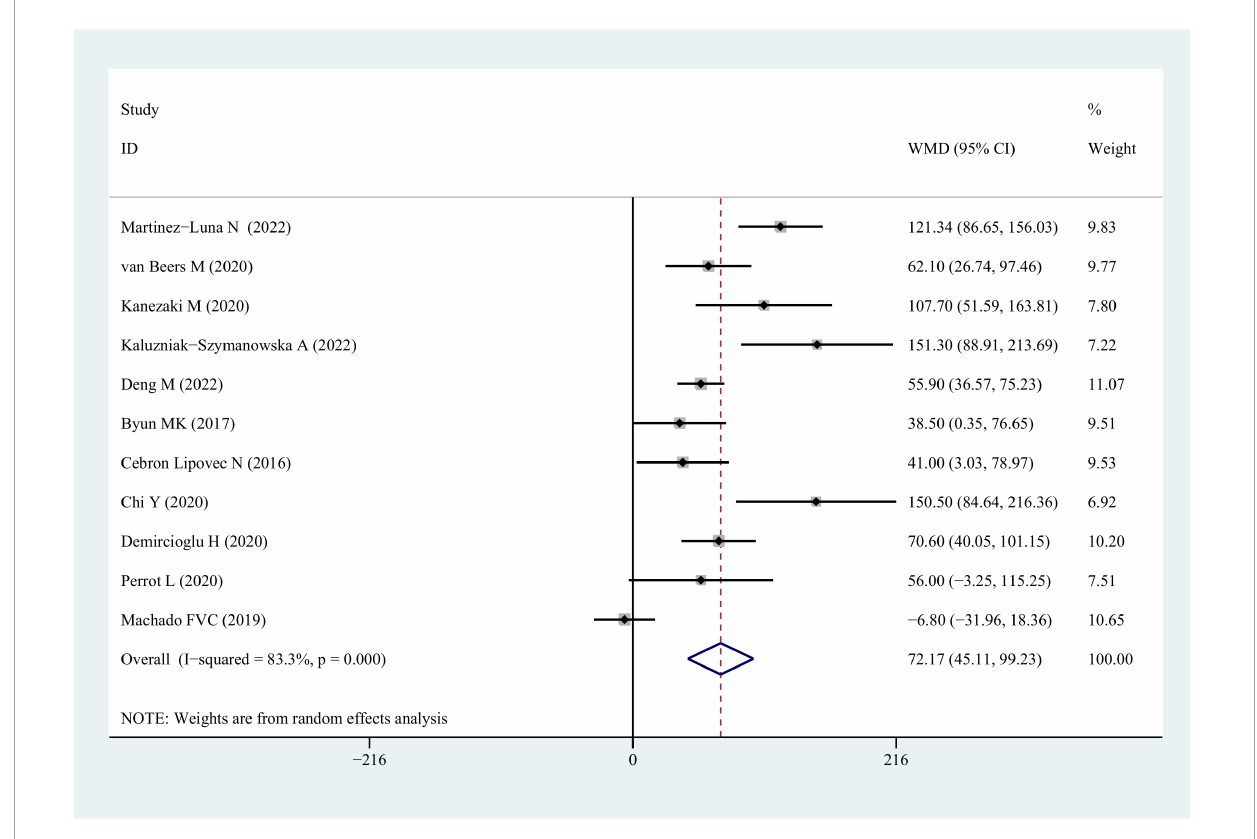
FIGURE5 WMD forest plot and its 95% CI for the 6-min walk test in COPD group and sarcopenia + COPD group. WMD, weighted mean